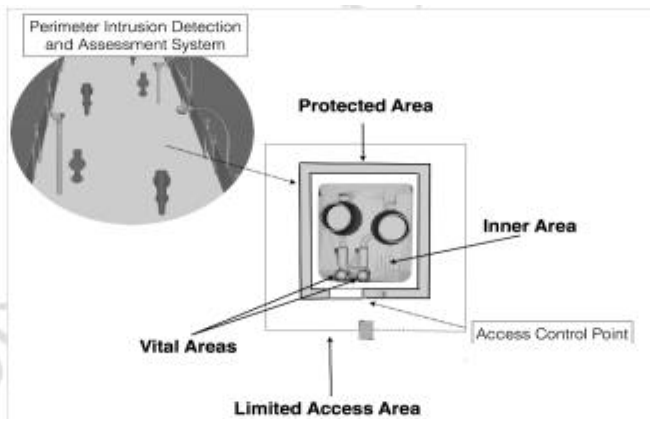
Figure 15. Illustration of types of security areas [ 19 ]